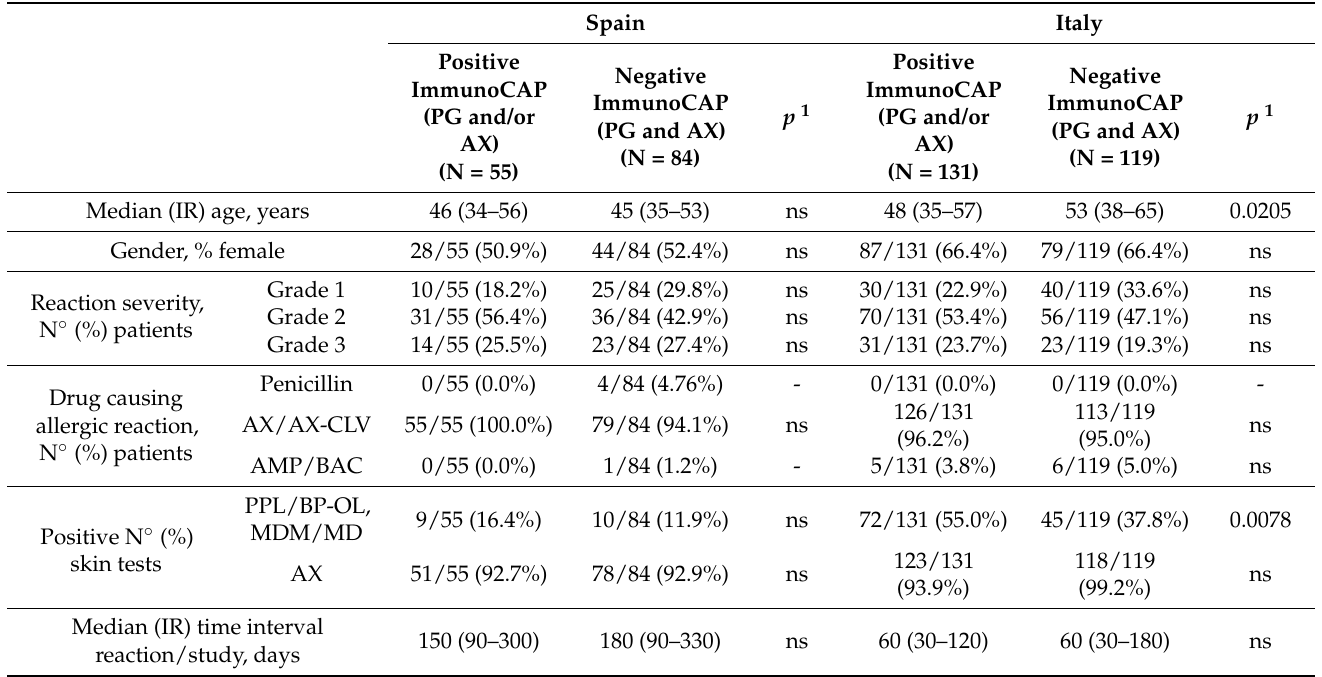
Table 2. Clinical characteristics and allergy work-up by specific IgE ImmunoCAP ® results (cut-off ≥ 0.1 kUA/L) for Spanish and Italian study groups. Statistical comparison shown is between positive and negative ImmunoCAP ® .